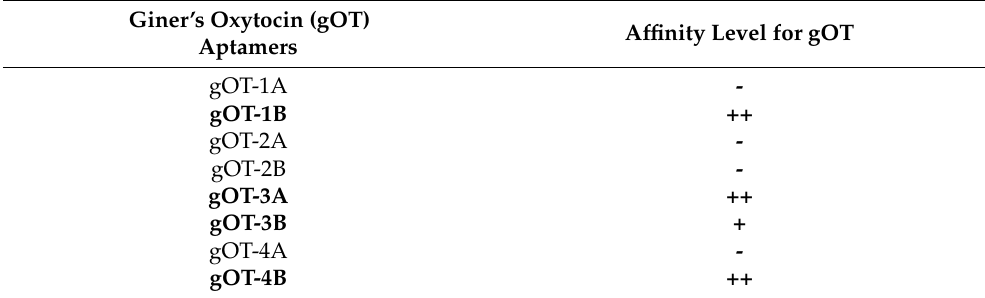
Table 2. Exemplar affinity results from impedance measurements. Affinity levels of each oxytocin aptamer (Raptamer) to oxytocin is denoted as “-” for no affinity, “+” for weak affinity and “++” for strong affinity. Giner’s Oxytocin (gOT) Affinity Level for gOT Aptamers gOT-1A - gOT-1B ++ gOT-2A - gOT-2B - gOT-3A ++ gOT-3B + gOT-4A - gOT-4B